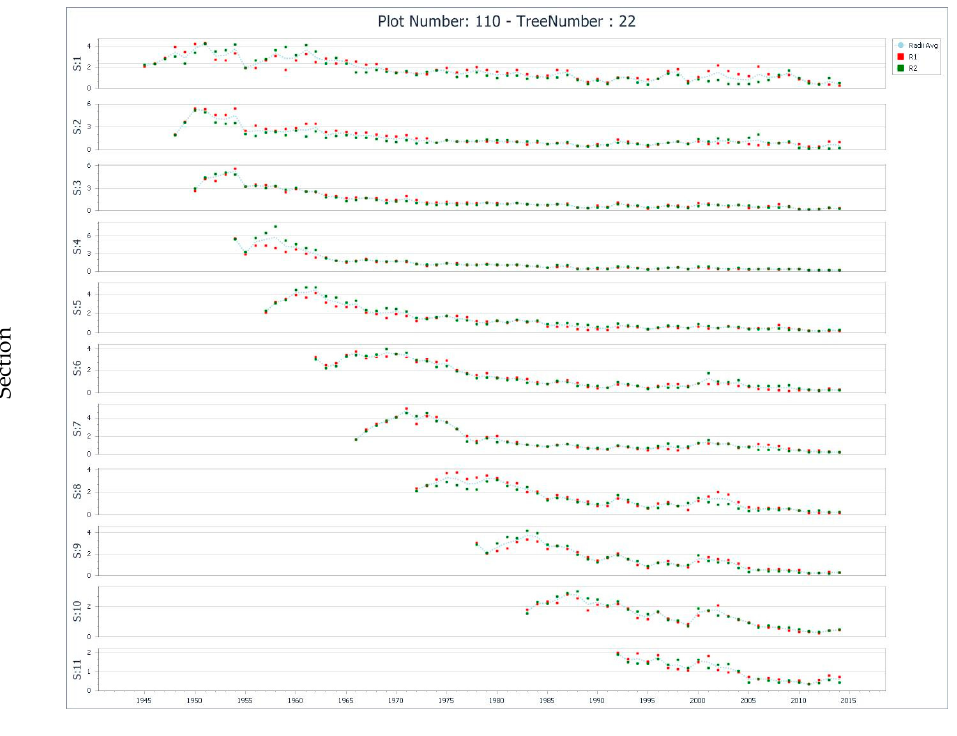
Figure 4. Data verification for the 70 year-old jack pine example tree: illustration of the annual increment widths (mm) by year, radii (denoted R1 and R2 in legend) and cross-section. Note, the (1) section denotations (S: 1–11; y-axis) refer to the sections sampled at stump height, breast-height, and 10%, 20%, 30%, 40%, 50%, 60%, 70%, 80% and 90% relative height positions, respectively, (2) mean trend line for each cross-section is superimposed, and (3) thinning treatments occurred in years 1962 and 1997.